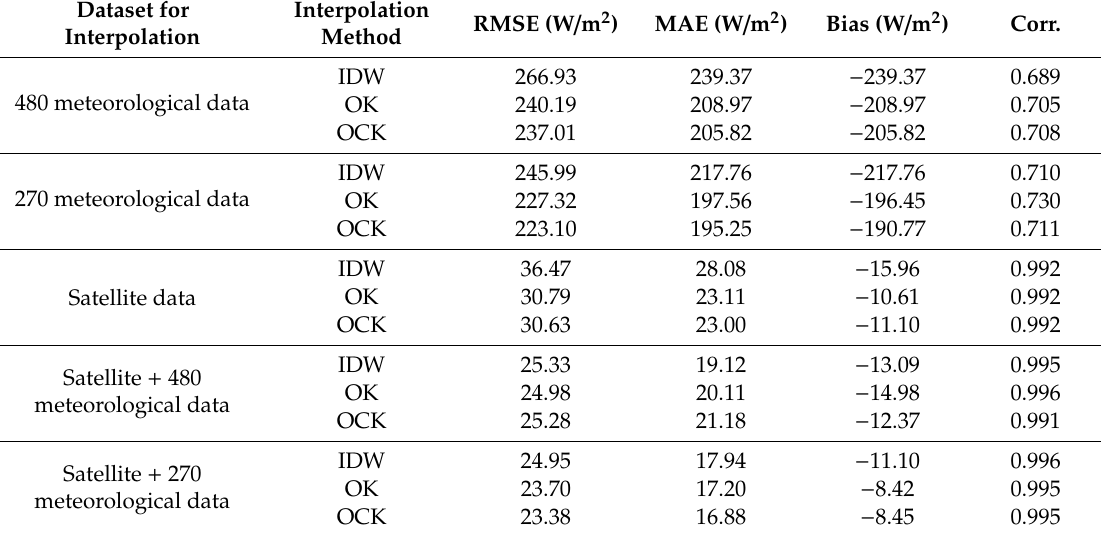
Table 3. Statistics of the comparison between buoy-derived wind power densities (WPD) and interpolated WPD at a height of 10